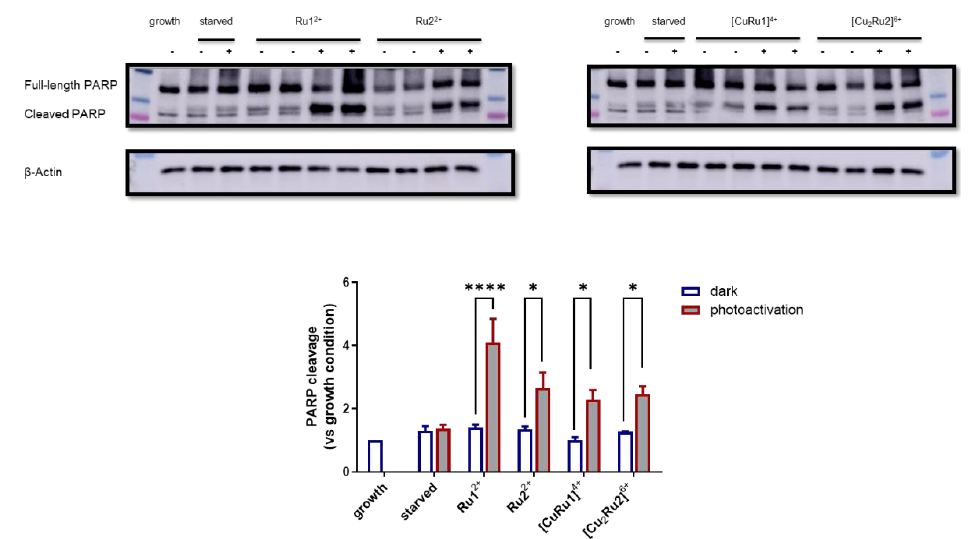
Figure 5. Effect of Ru(II) complexes on PARP cleavage in ovarian cancer cells after photosensitization. A2780 cells were treated for 24 h with each Ru(II) complex before being photoactivated and collected after 24 h of light irradiation. Western blot analysis was performed in 30 µ g total cell lysates using specific anti-PARP (46D11) antibody. Densitometric analysis of cleaved form of PARP was performed in three independent experiments conducted in duplicate. Data are the mean ± SEM and are reported as cleaved protein levels normalized to β -actin, fold change over FBS control. Results are statistically significant according to two-way ANOVA followed by Bonferroni post hoc test: * p < 0.05, **** p < 0.0001.